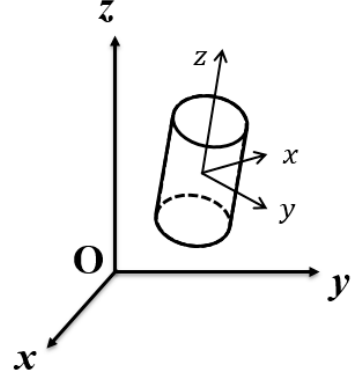
Figure 2. Coordinate systems of buoys.